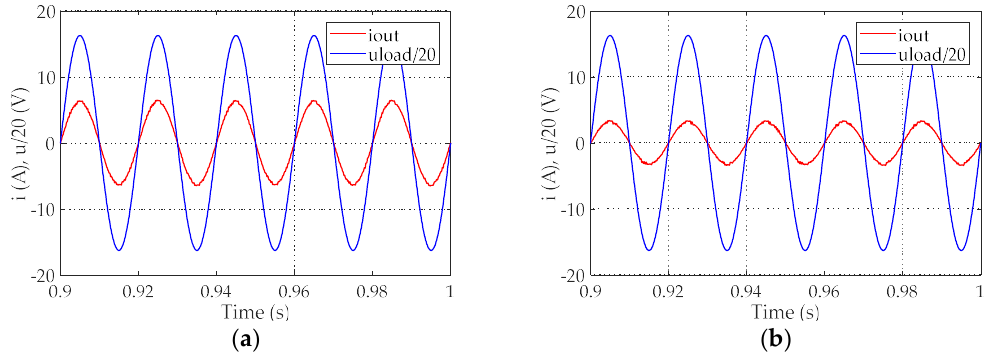
Figure 10. Output current and point of common coupling (PCC) voltage signals for: ( a ) prosumer 1; ( b ) prosumer 2.